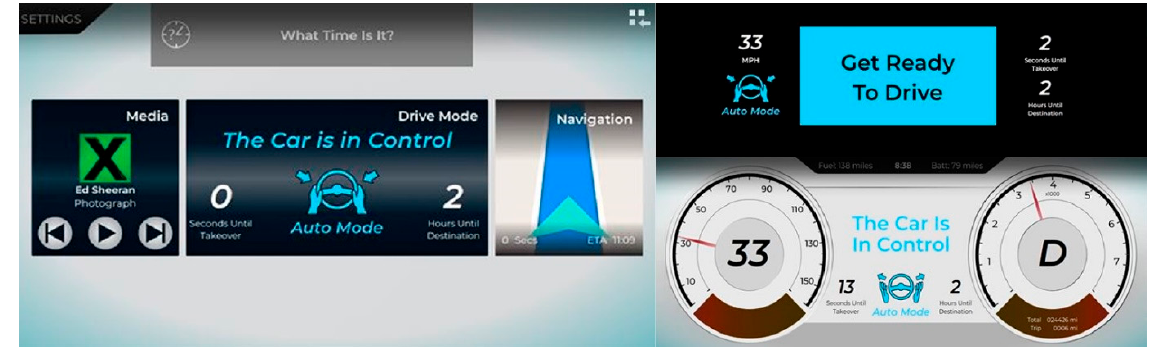
Figure 7. This illustrates the three visual aspects of the HMI, on the left is the central console, bottom right is the cluster, and the HUD is shown at top right.